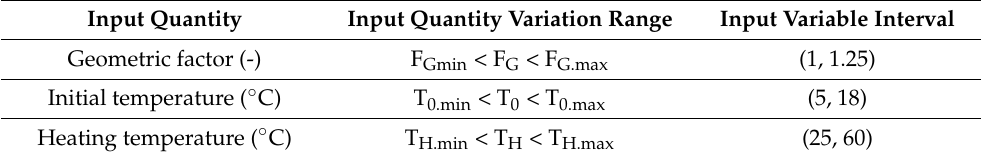
Table 3. Input quantities of the experimental design and their variation intervals.